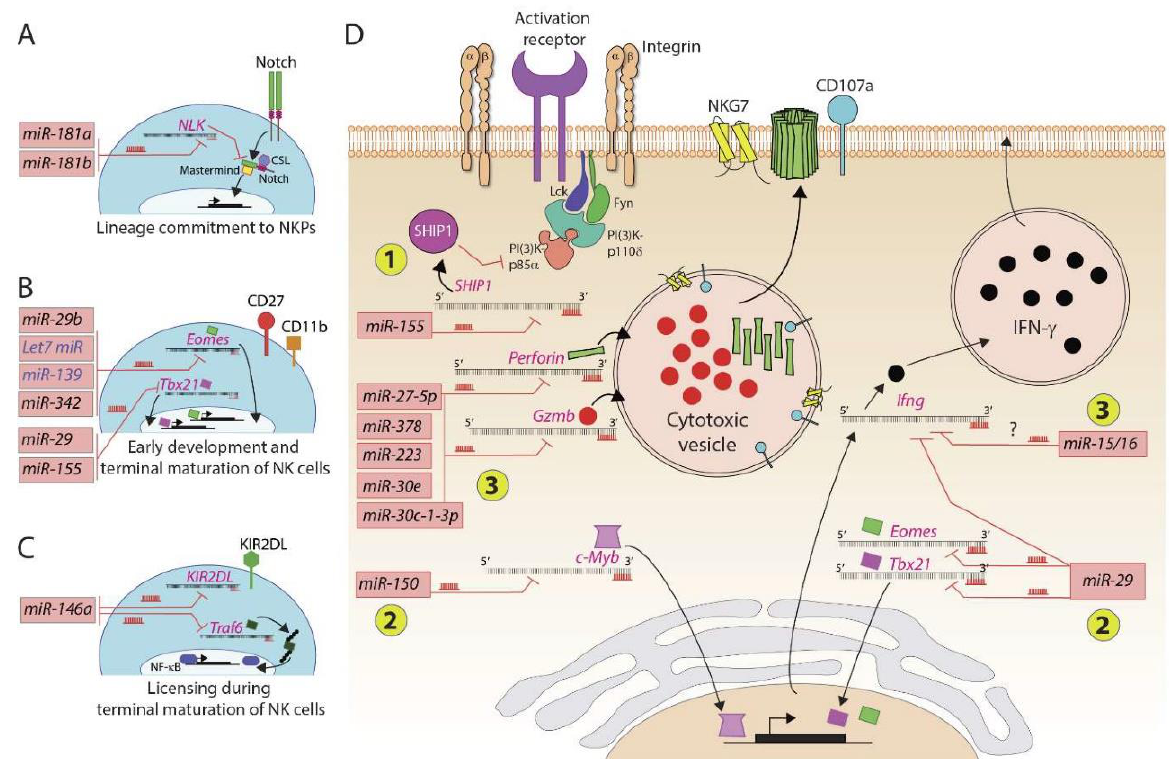
Figure 2. MicroRNAs regulate murine and human NK cell development and functions. Several microRNAs play an essential role in positively or negatively regulating the NK cell ontogeny. ( A ) Lineage commitment of progenitors to NKPs is regulated by miR-181a and miR-181b that target the transcript encoding NLK, a negative regulator of Notch signaling. ( B ) Early development and terminal maturation of NK cells are regulated by several miRNAs. The primary target of these miRNAs is the transcripts of transcription factors, including Eomes and Tbx21. ( C ) MicroRNA miR-146a targets transcripts encoding KIR2DL and TRAF6. KIRs interact with self MHC Class I and thereby determine the threshold of activation and licensing during the terminal maturation of NK cells. ( D ) MicroRNAs regulate the effector functions of NK cells. These regulatory effects occur at three levels: (1) miR-155 degrades the transcript encoding lipid phosphatase SHIP that converts PI(3,4,5)P 3 into PI(3,4)P 2 ; conversely, an increase in the concentration of PIP 3 augments the overall activation of NK cells; (2) miR-29 and miR-150 target messages encoding transcription factors, including Eomes, Tbx21, and c-Myb; (3) several